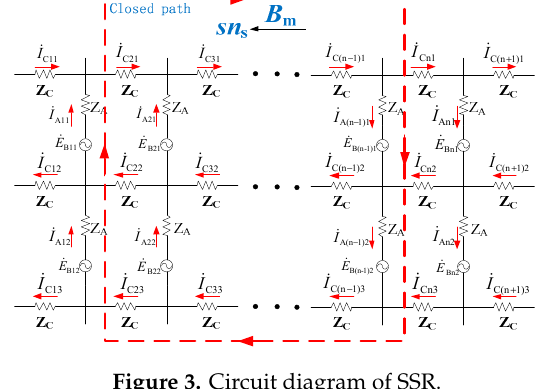
Figure 3. Circuit diagram of SSR.